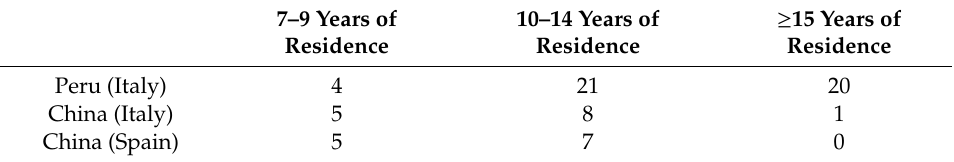
Table 1. Years of residence in the (host) country of the interviewed